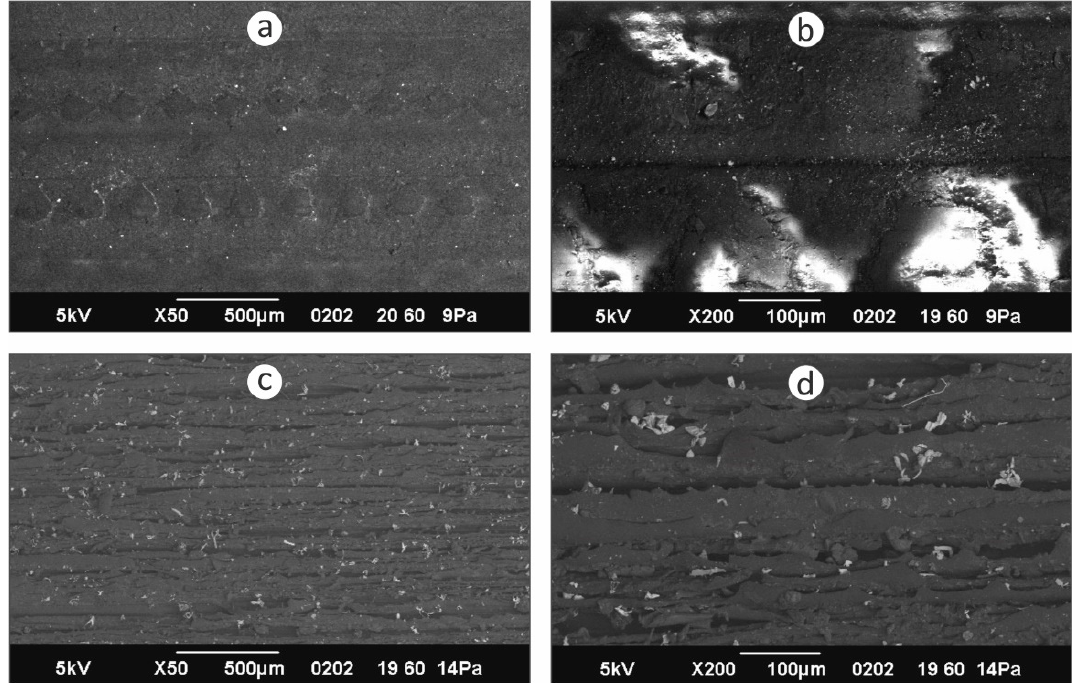
Figure 12. SEM images taken on the specimen built with X = 0, Y = 0 deposition angle: ( a ) top surface X50 zoom level; ( b ) top surface X200 zoom level; ( c ) side surface X50 zoom level; ( d ) side surface X200 zoom